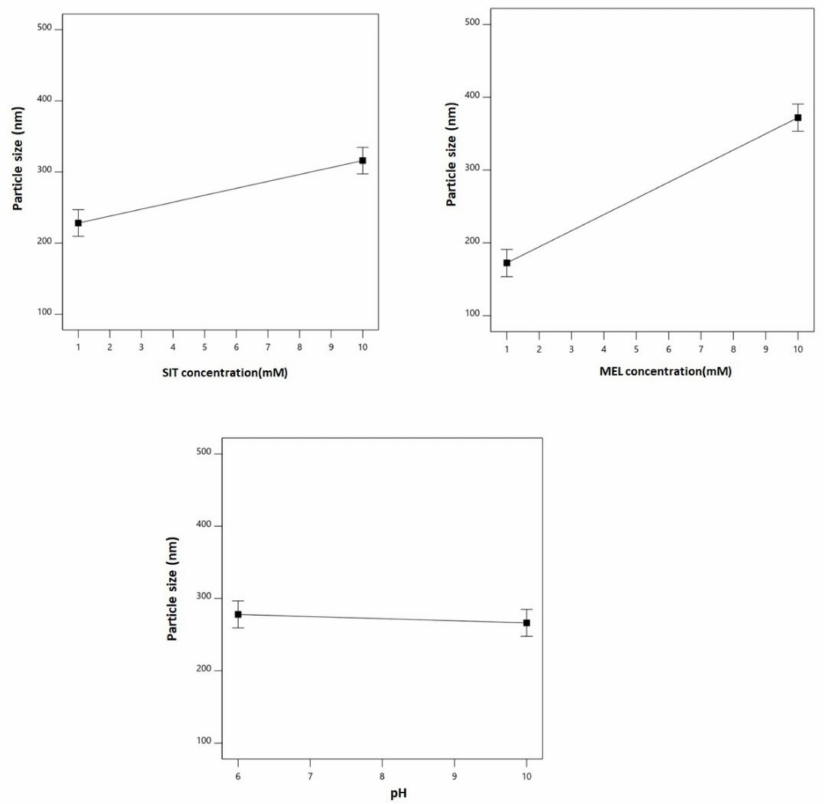
Figure 2. Main effects of SIT concentration (X 1 ), MEL concentration (X 2 ), and pH (X 3 ) on particle size of SIT-MEL nano-sized